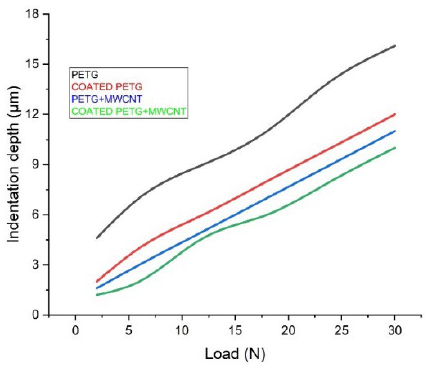
Figure 18. Indentation depth vs. load.